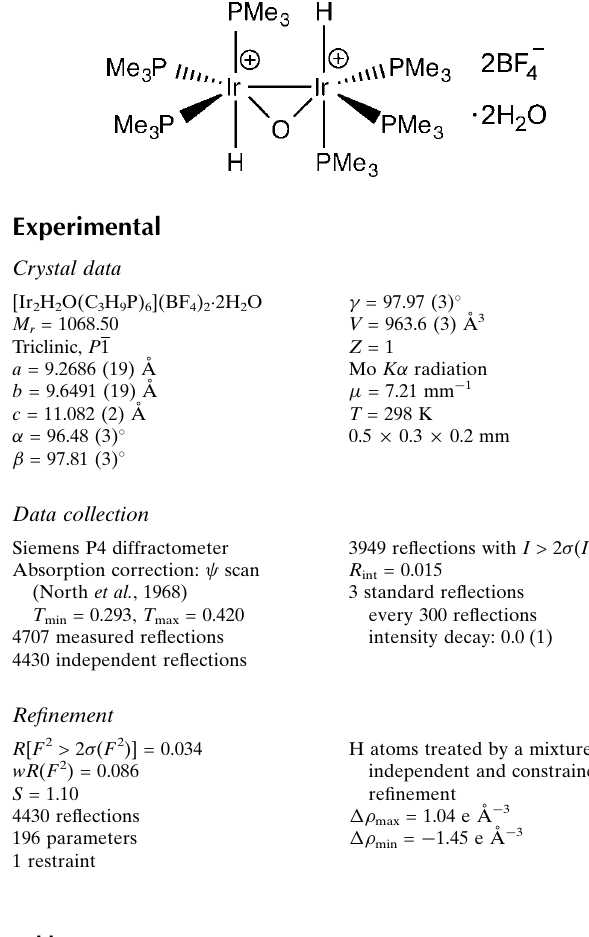
Siemens P4 diffractometer Absorption correction: